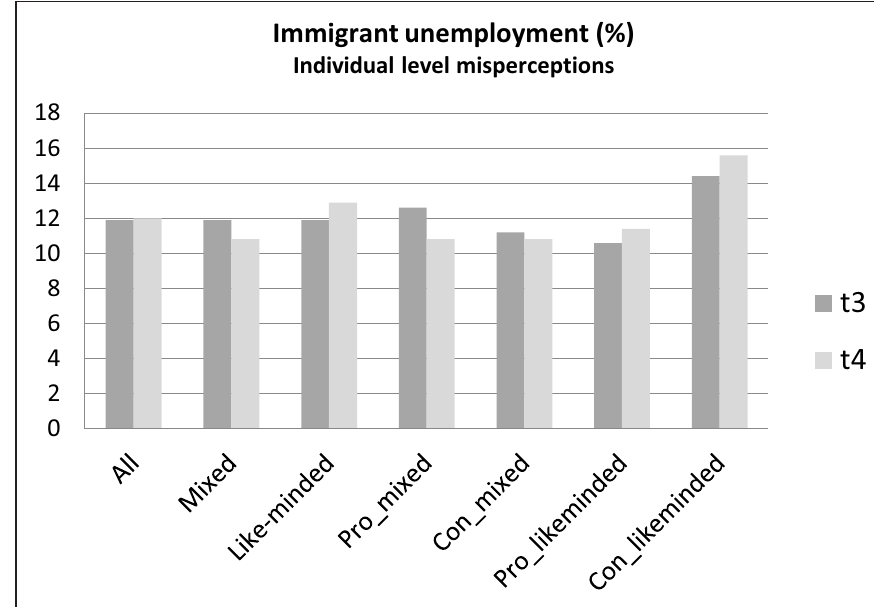
Figure 3: Misperceptions measured before (t3) and after (t4) deliberation across treatments and